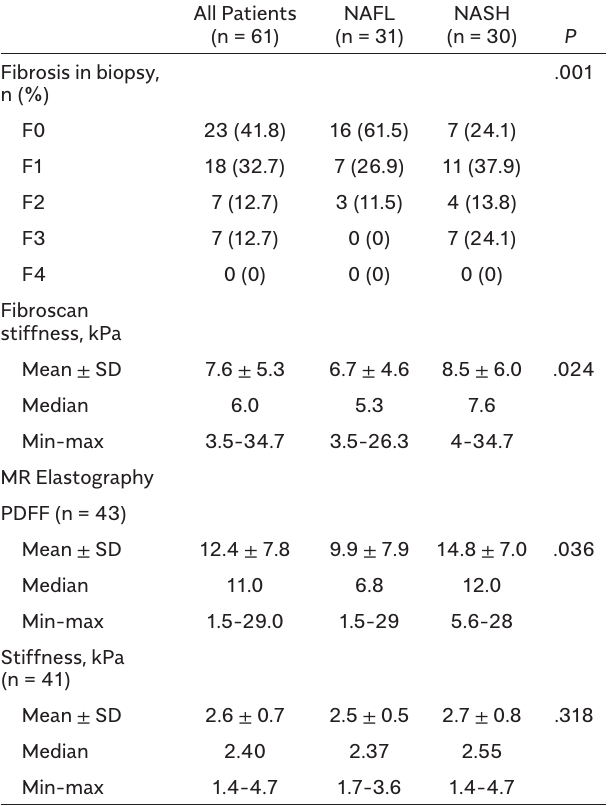
Table 2. Evaluation of Hepatic Steatosis and Fibrosis All Patients (n = 61)